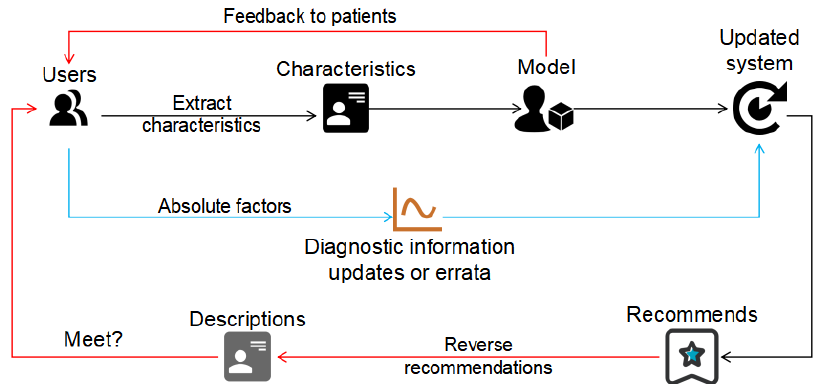
Figure 2. Presented recommendation system. Note. The black lines stand for traditional recommendation systems. The blue lines stand for unexpected limitations. The red lines indicate the reverse recommendation progress.